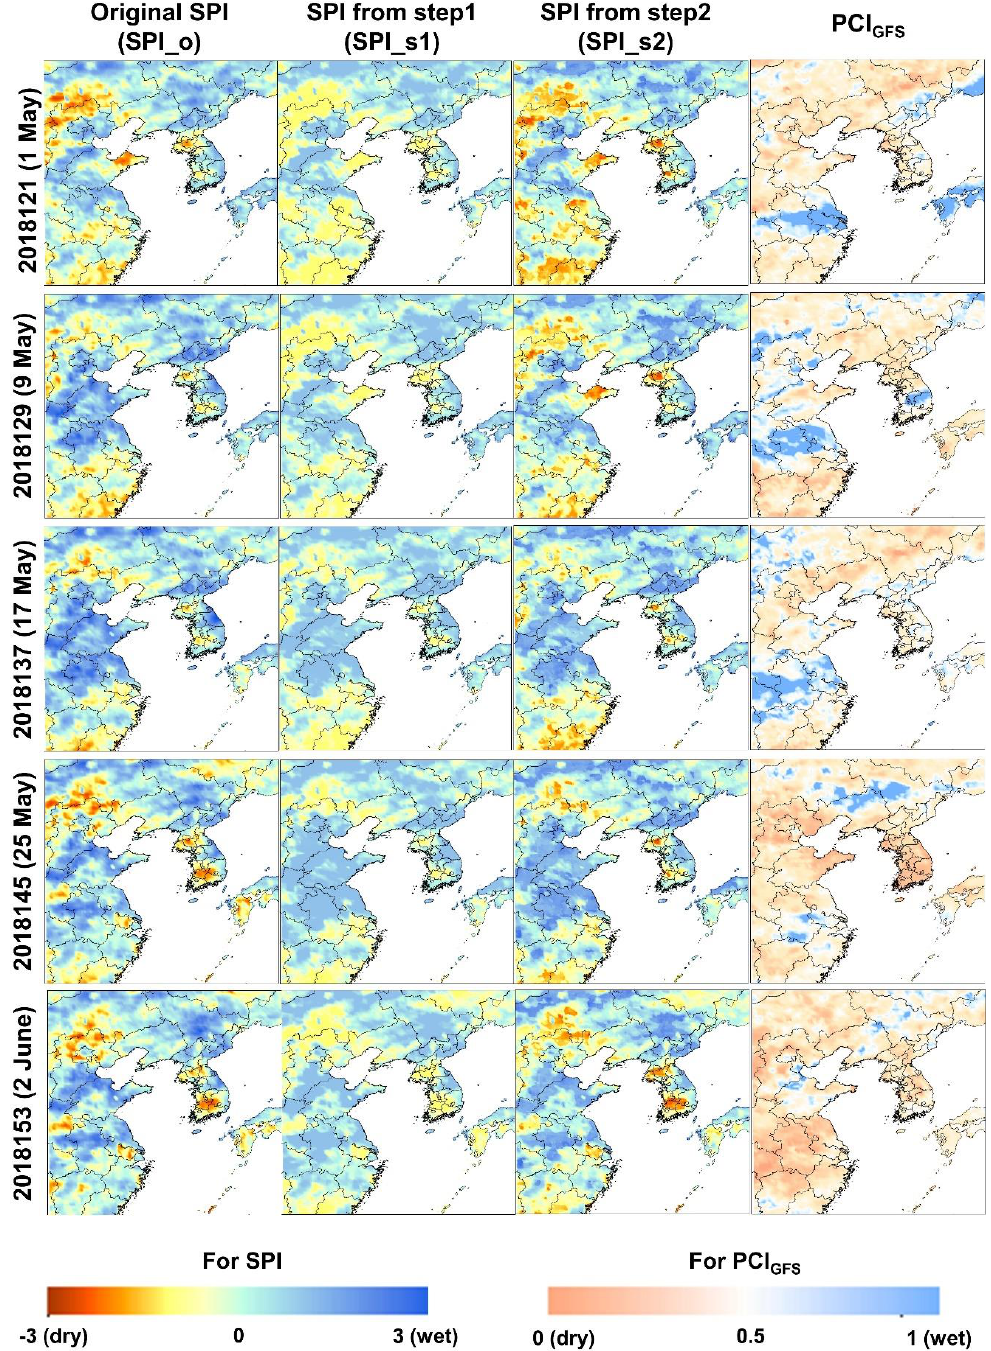
Figure 8. Spatial distribution of forecasted SPI from 1 May to 2 June. The vivid red and blue present dry and wet conditions, respectively, in the SPI maps (i.e., reference SPI (SPI_o), SPI from step1 (SPI_s1) and SDCI from step2 (SPI_s2)). The light red and blue present dry and wet conditions, respectively, using precipitation (PCI GFS ) from Global Forecasts System (GFS).